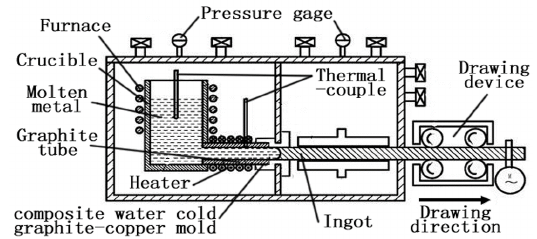
Figure 1. Schematic of continuous casting